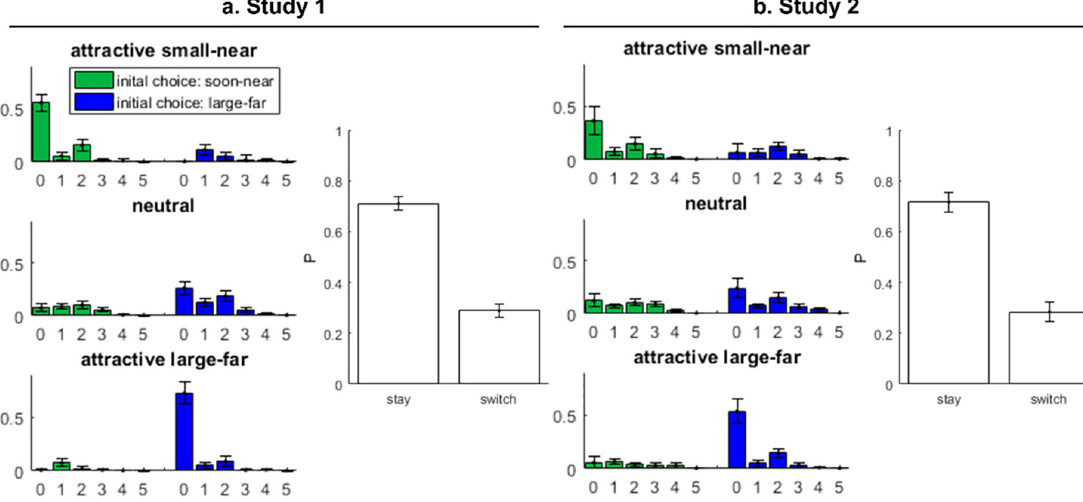
Fig 5. Choice results of studies 1 and 2. a) Results of study 1 show oscillatory switching in relative switch frequencies (left sub-panel) and choice perseveration (right sub-panel) as predicted by the model. B) Results of study 2 confirm the results of study 1. Error bars mark 95% confidence